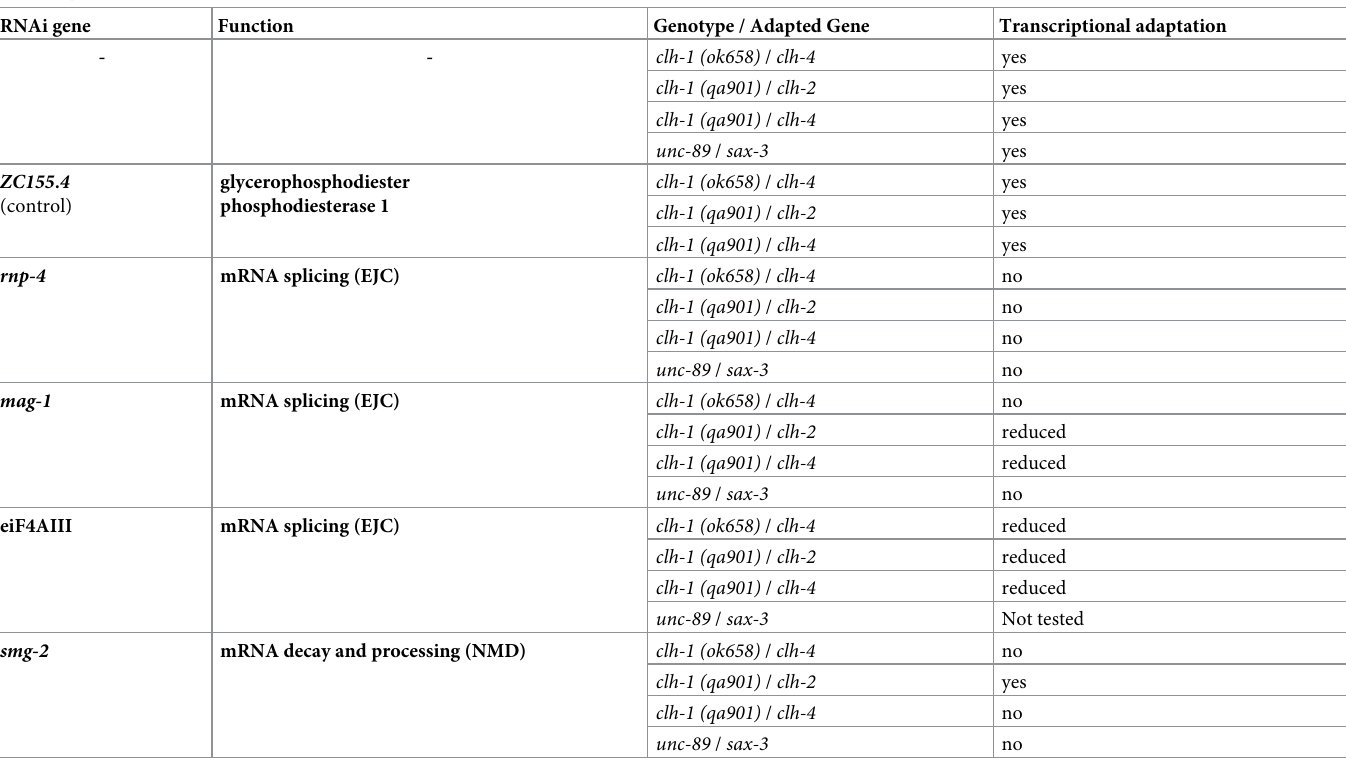
Table 2. Summary of the effects of knocking down control gene ZC155 . 4 , rnp-4 , mag-1 , eiF4AIII, and smg-2 on transcriptional adaptation. “Yes” indicates that the gene is either up or down-regulated, “no” indicates no change in transcript level as compared to wild type, and “reduced” indicates that the indicated genes were up or down-regulated but not to the same extent as in control